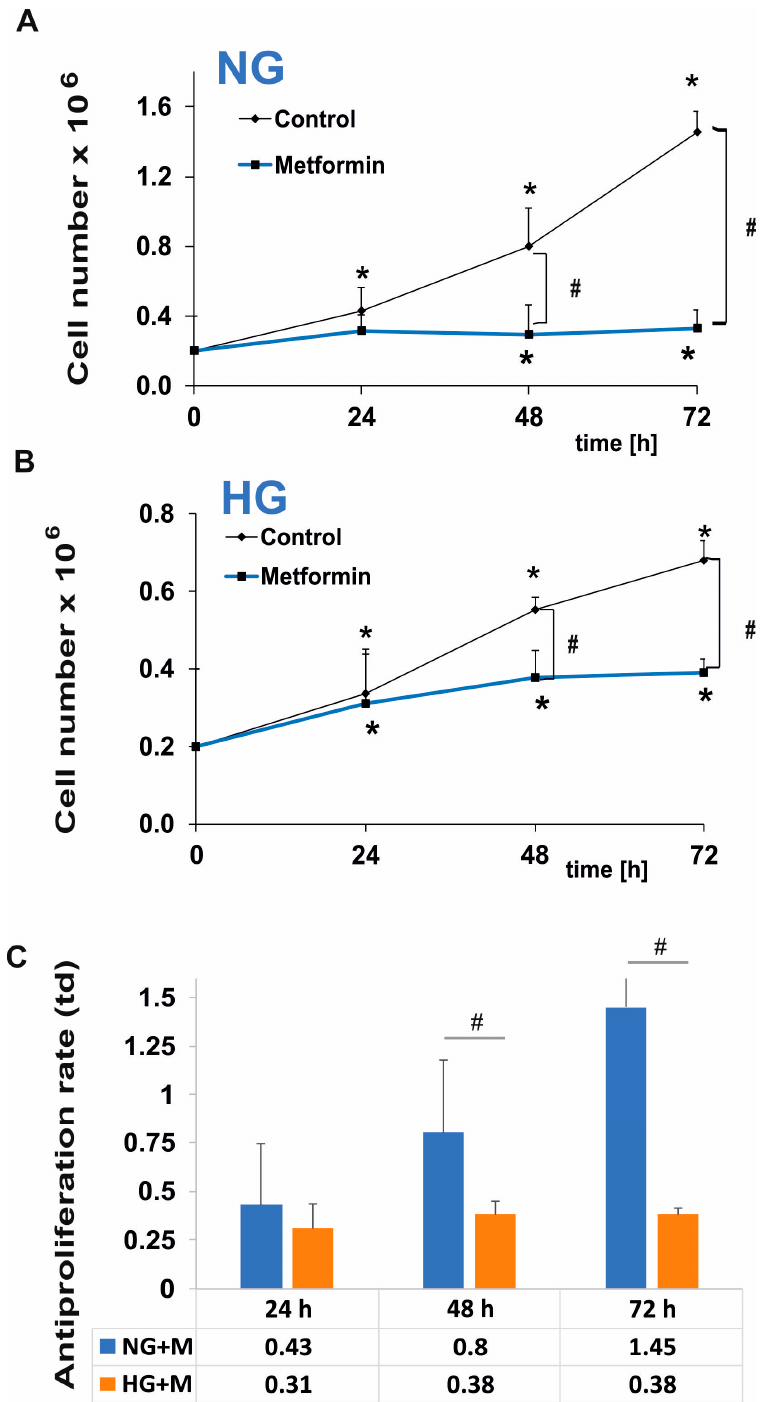
Figure 1. Antiproliferative action of metformin in SKOV-3 cells is reduced by hyperglycemia. SKOV-3 cells were cultured in normoglycemia ( A ) and hyperglycemia ( B ) and simultaneously treated with 10 mM metformin for 24, 48, 72 h. The cell number was determined using the trypan blue method and the proliferation rates were calculated ( C ). NG + M—cells cultured in normoglycemia and treated with metformin, HG + M—cells cultured in hyperglycemia and treated with metformin, td—proliferation rate. Results are presented as means ± SD of four independent experiments. (*) Statistically significant differences in comparison to untreated cells at time point “0”, p < 0.05; (#) statistically significant differences between the cells exposed to metformin in comparison to unexposed cells at the same time point, p < 0.05.